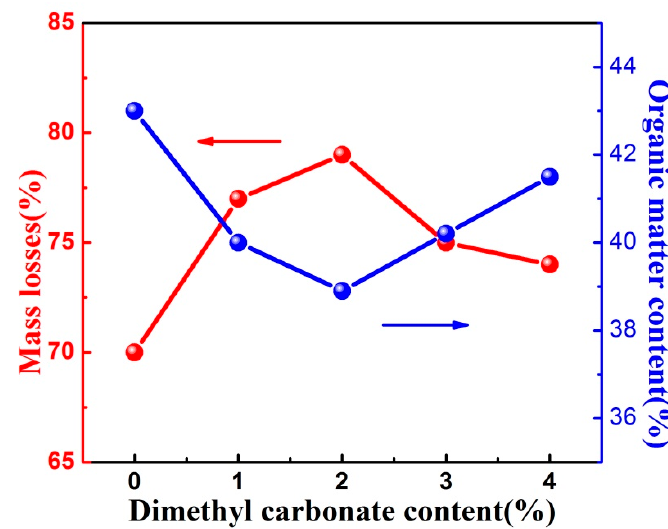
Figure 2. Mass loss of the sludge and content of the organic matters with respect to the content of the dimethyl carbonate during the process of the microwave treatment.